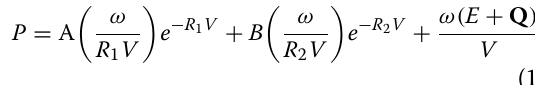
relationship between the interior energy and tempera- ture in the ideal gas equation of state (Eq. 2) was used to determine the afterburning start and end times. (Schwer, 2016) In the explosions of 2 kg and 3 kg of TNT, the interior energy at an interior tempera- ture of 900 K was calculated to be 1.501E 2.225E 09 J, respectively: +